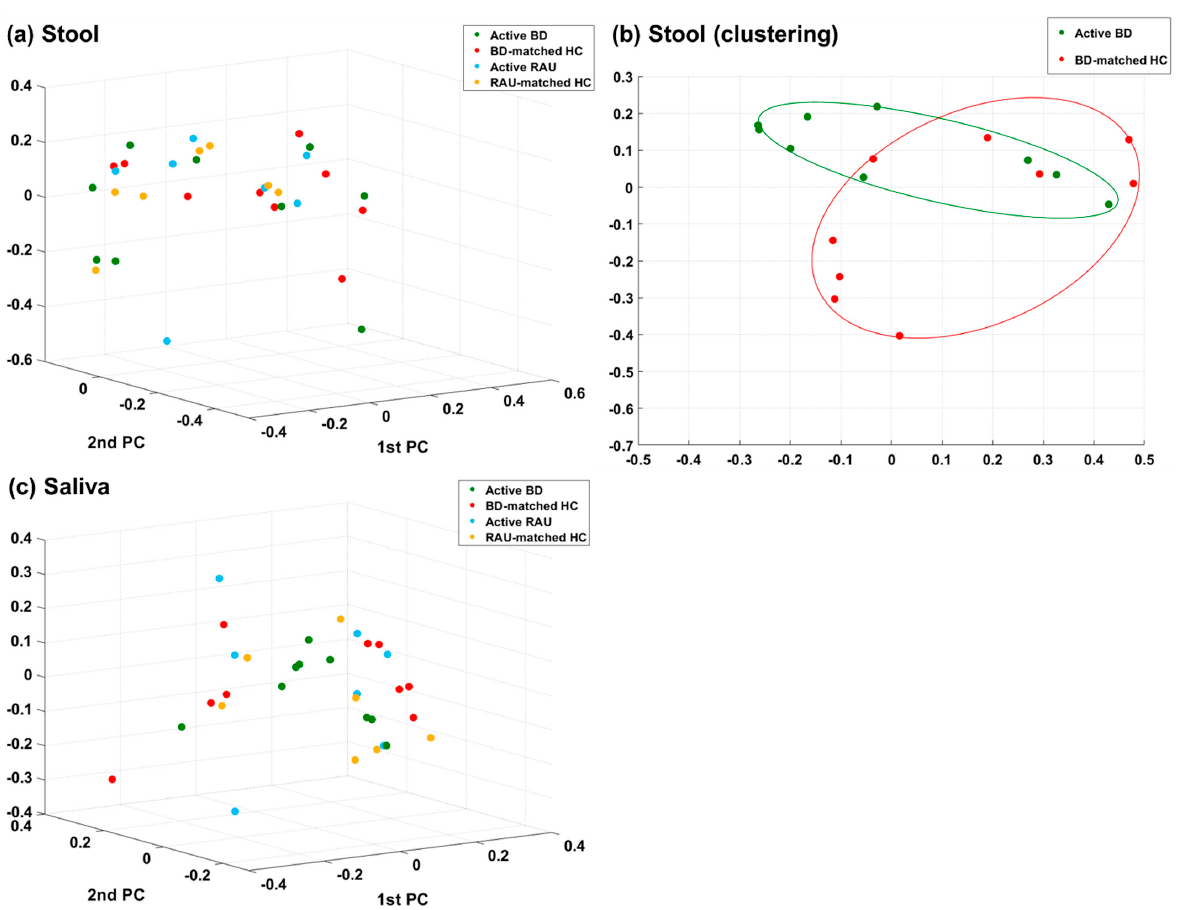
Figure 2. Comparison of the taxonomic beta diversities of the microbiome of the active BD (green), BD-matched HC (red), active RAU (blue), and RAU-matched HC (yellow) groups. Differences in beta diversity between the groups were visualized using Bray–Curtis principal coordinate analysis (PCoA) plots in a three-dimensional space. The significant p -values of the differences in beta diversity between the groups were evaluated using permutational multivariate analysis of variance (PERMANOVA). In stool ( a ) and saliva ( b ), there were no significant differences in the beta diversity between groups. However, a distinguishable clustering of the active BD group compared with the BD-matched HC group was noted in stool ( c ). BD, Behçet’s disease; RAU, recurrent aphthous ulcer; HC, healthy control.